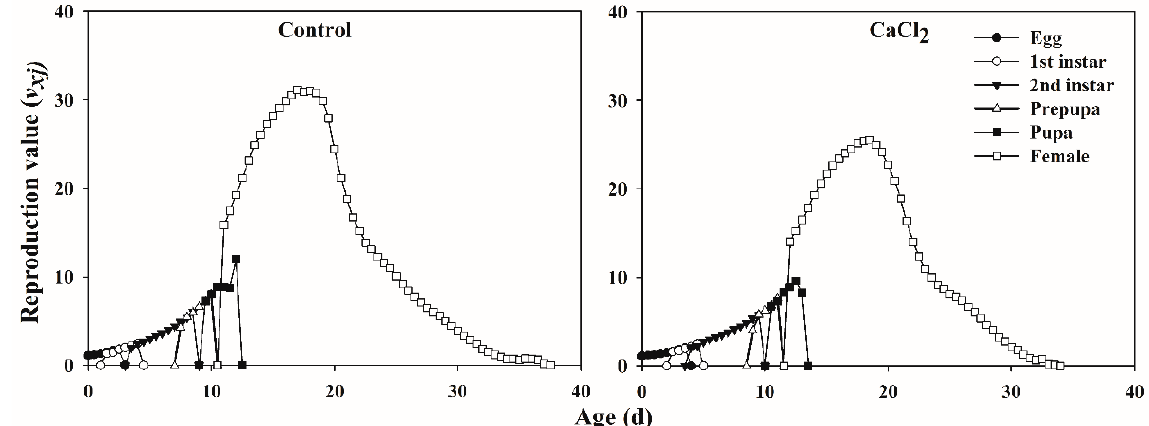
Figure 4. The age-stage-specific reproduction value ( v xj ) of Frankliniella occidentalis fed on control and Ca-treated kidney